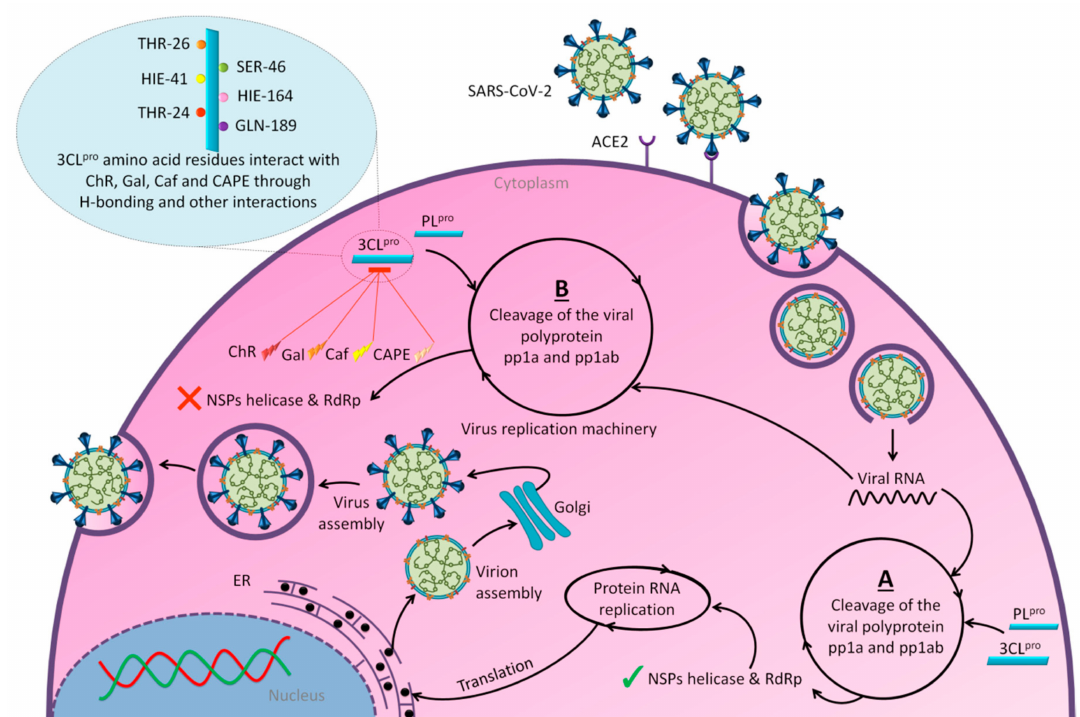
Figure 7. The potential antiviral mechanisms of action for honey contain ca ff eic acid, CAPE, galangin, and chrysin against SARS-CoV-2. Through an endosomal pathway, SARS-CoV-2 enters the host cell upon binding its S protein to the cellular receptor ACE2. ( A ) The viral RNA is unveiled in the cytoplasm and the pp1a and pp1ab polyproteins cleaved by the proteases (3CL pro and PL pro ) to form nonstructural proteins (nsps) as helicase (for viral RNA synthesis) and the RNA replicase–transcriptase complex (RTC), which includes RNA-dependent RNA polymerase (RdRp) (for virion assembly). RdRp is responsible for the replication of structural protein RNA. The nucleocapsids residing in the cytoplasm are assembled from genomic RNA, whereas the structural proteins S1, S2, E, and M are translated by ribosomes in the endoplasmic reticulum (ER), and then released for preparation of virion assembly. The structural proteins then fuse with virion assembly to virus assembling, which is then transported through the Golgi apparatus to be released via exocytosis. ( B ) When honey containing ca ff eic acid (Caf), CAPE, galangin (Gal), and chrysin (ChR) is being consumed, those compounds could enter the infected cells and inhibit 3CL pro . This inhibition is based on the chemical interactions of these compounds with 3CL pro amino acid residues; (1) Caf with GLN-189, HIE-164 through hydrogen (H) bonding, and with HIE-41 through π – π stacking interaction. (2) CAPE with THR-24 and THR-26 through H-bonding, and with HIE-41 through π – π interaction. (3) Chr with SER-46, THR-24 and THR-26 through H-bonding, and with HIE41 through π – π interaction. (4) Gal with SER-46 and THR-24 through H-bonding, and with HIE-41 through π – π interaction. As a result, the process of pp1a and pp1ab polyprotein cleavage will fail to form nsps and RdRp, which means that protein replication cannot be completed and finally, SARS-CoV-2 replication will be